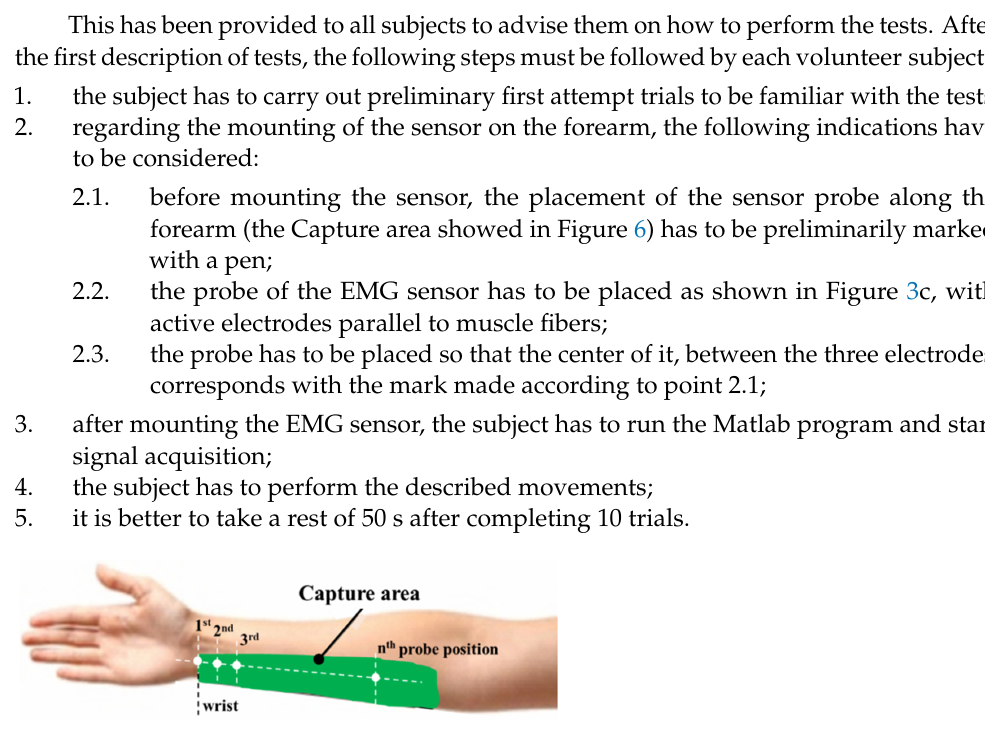
Figure 6. Effective area for the placement of the EMG sensor probe. The white points represent the positions of the sensor probe. For the sake of clarity, the distance between two consecutive positions is more than 10 mm.